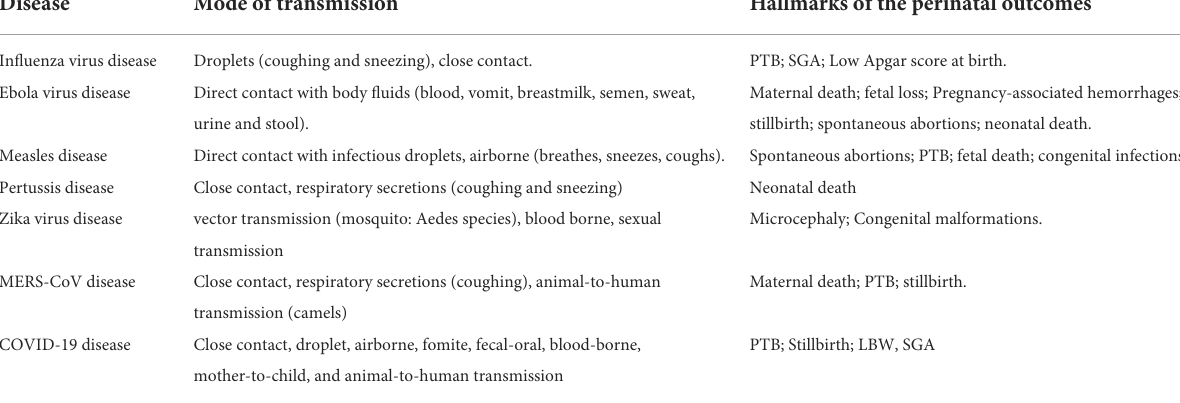
TABLE 2 The hallmarks of the perinatal impacts of the described emerging and re-emerging infectious diseases. Disease Mode of transmission Hallmarks of the perinatal outcomes Influenza virus disease Droplets (coughing and sneezing), close